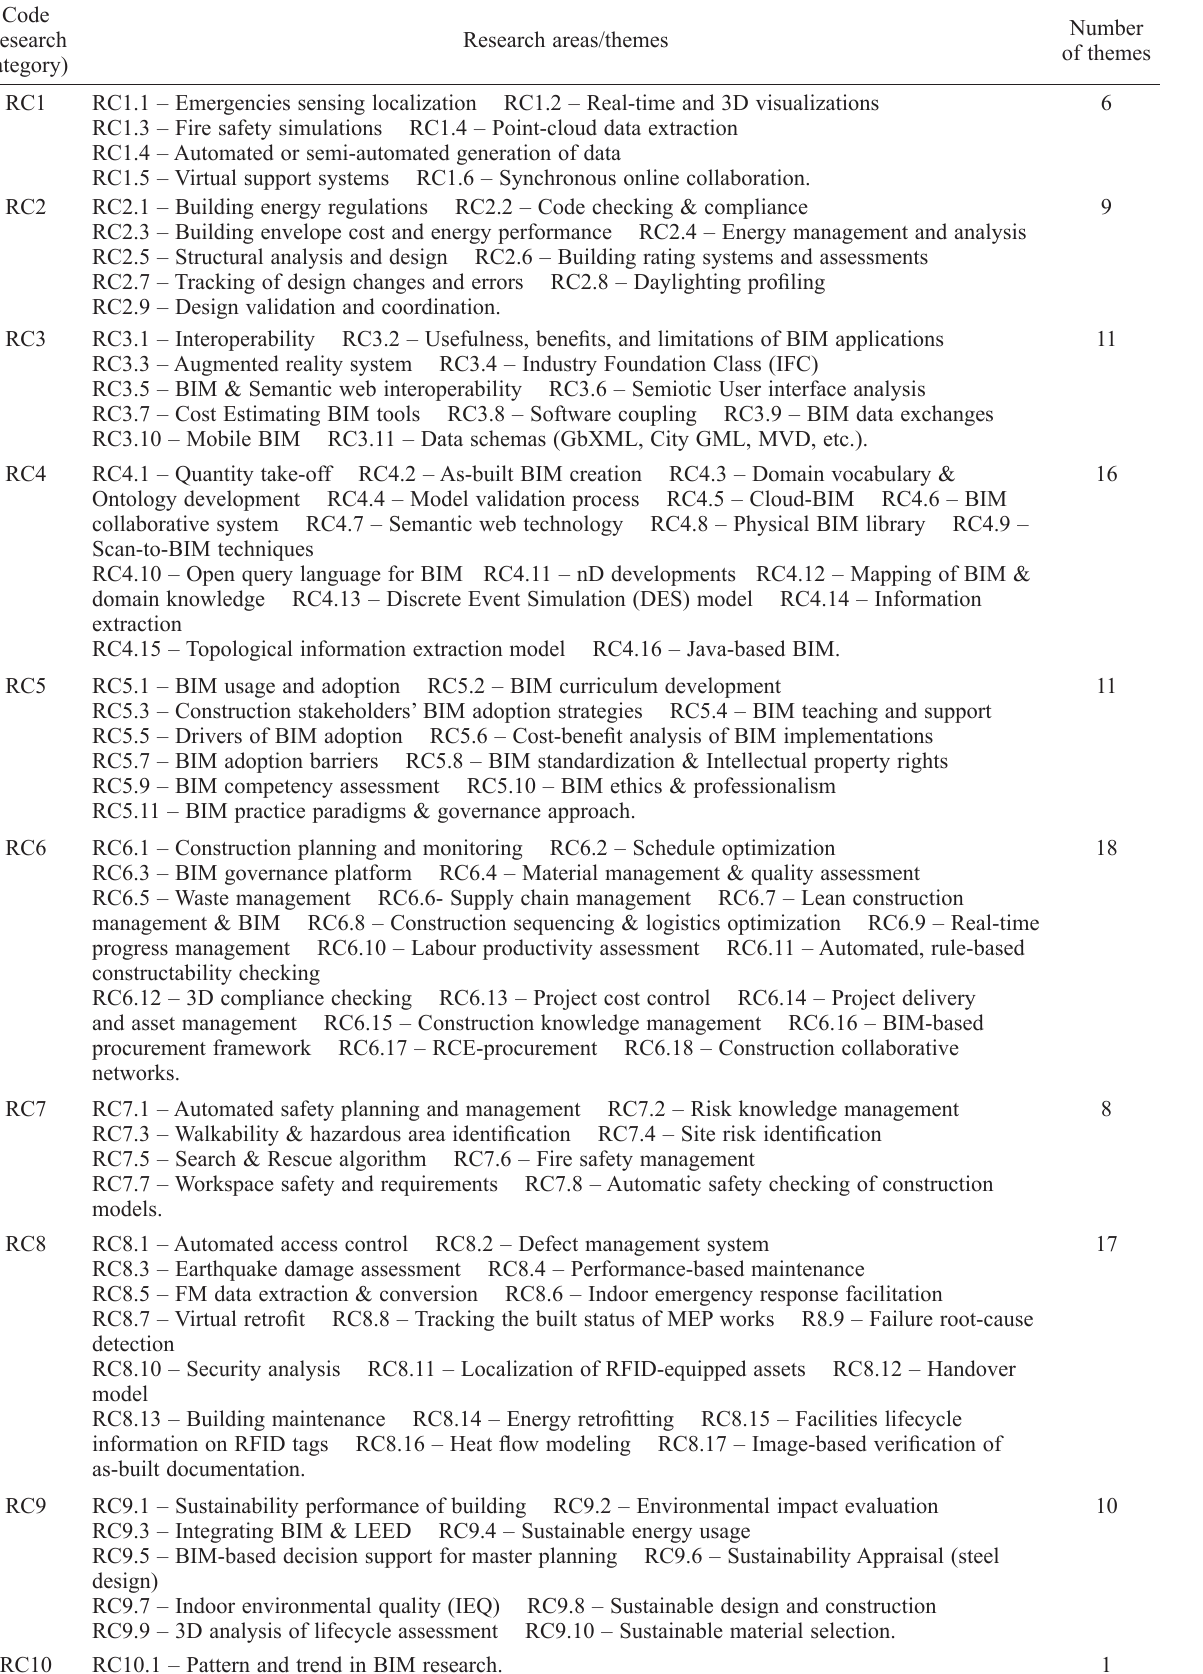
Table 6. Theme loading for the BIM research